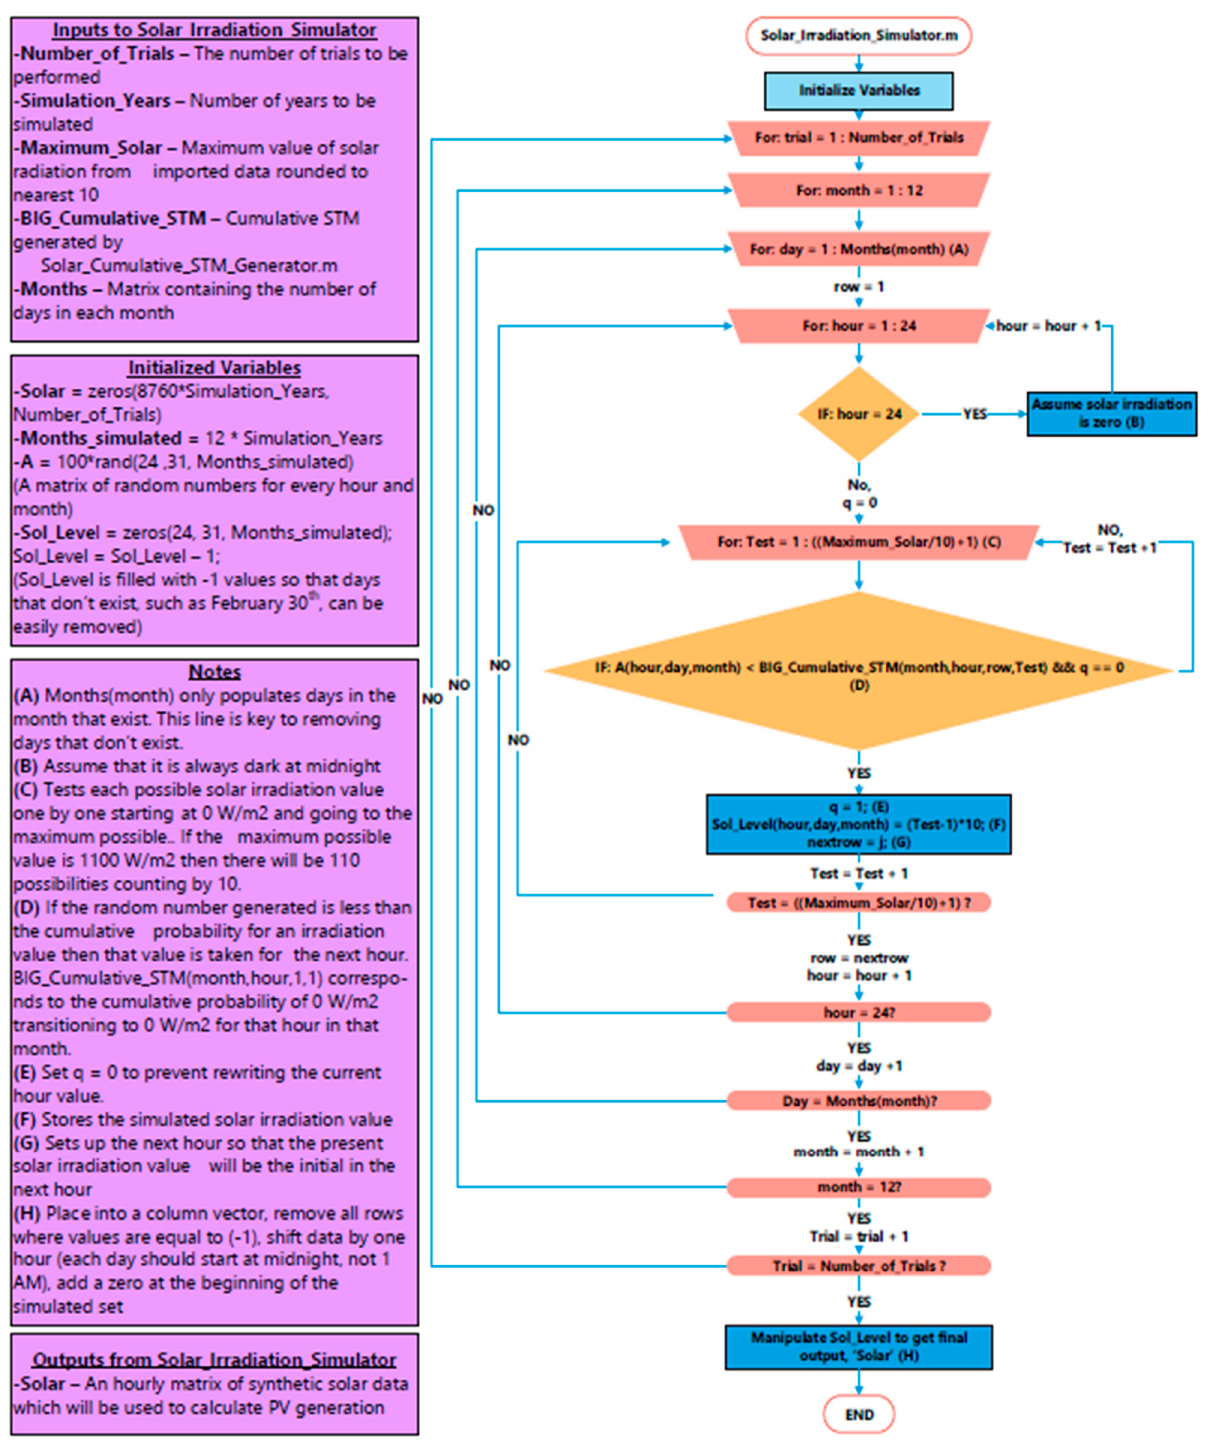
Figure A3. Flow chart describing “Solar Irradiation Simulator.m”. Outputs an hourly matrix of synthetic solar data which will be utilized by PV Output Calculator.m to evaluate PV generation for each hour.